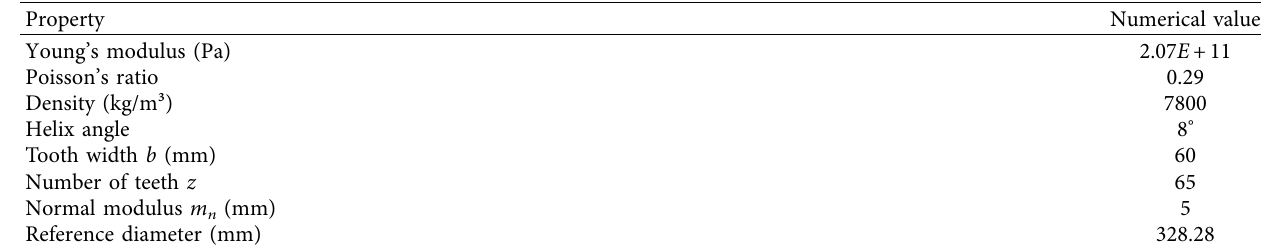
Table 1: Te gear